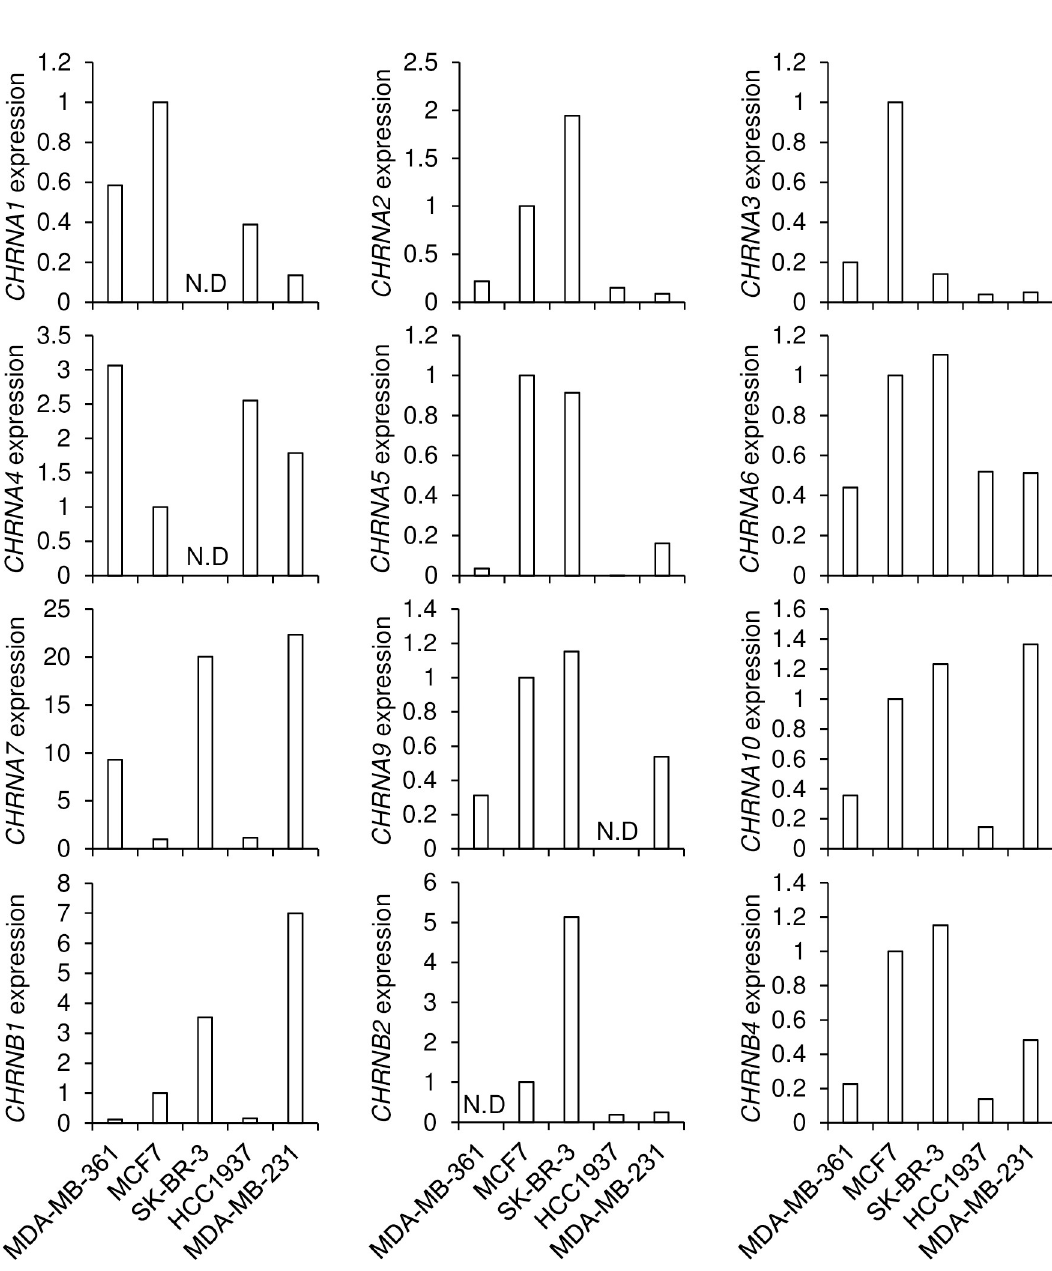
Fig 6. The expression of nAChR subunits in breast cancer cells. The relative mRNA expressions of nAChR subunits in breast cancer cell lines was measured by qPCR. The values were relative to the mRNA expressions of MCF7 cells. N.D.: Not detected.